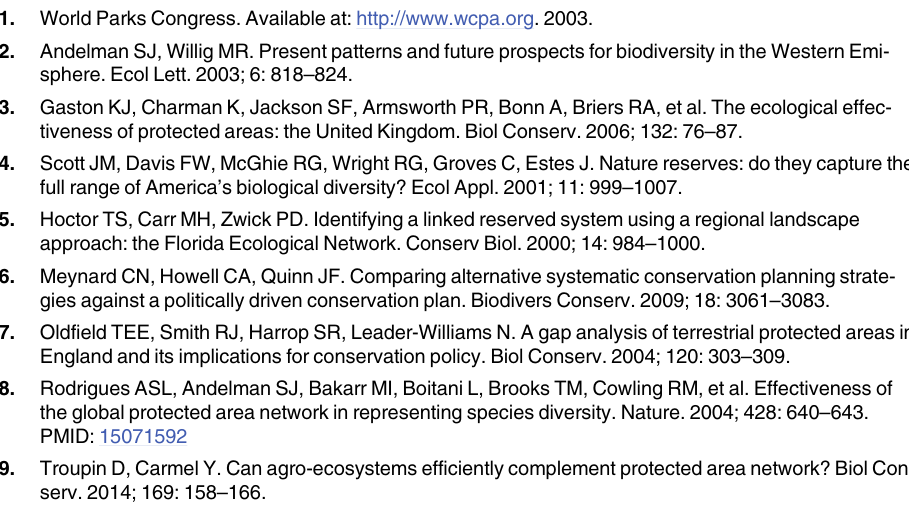
S1 Table. Land use variables used for cluster analysis and as predictors in the multiple lin- ear regression to assessing bird diversity hotspots in Southern Italy. S2 Table. Landscape Units (LU), length of transects and number of point counts carried out in the research. Density of sampling transects (1 km/km 2 ) and sampling points (1 point/ km 2 ) are showed as well. S3 Table. Landscape Units defined by cluster analysis and used to randomly allocate sam- pling transects and sampling point counts. S4 Table. Species observed during the winter (W) and the breeding season (B). For each spe- cies is indicated if it is listed in the Italian Red List; EN = Endangered, VU = Vulnerable, NT = Near Threatened, LC = Least Concern, DD = Data Deficient, NA = Not Applicable), in the Annex I of the Birds Directive 2009/147/CE, and the SPEC